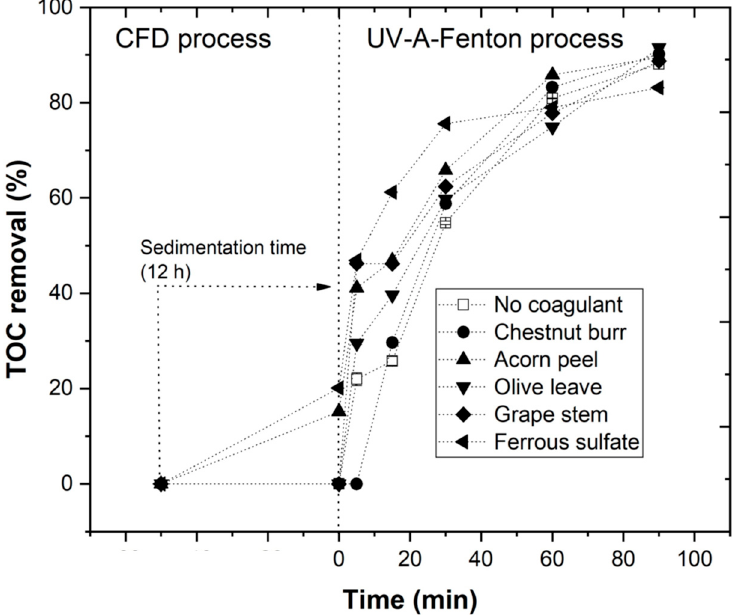
Figure 12. Progress of TOC percentage removal after CFD (with plant-based coagulants chestnut burr, acorn peel, olive leaf, and grape stem) and the UV-A-Fenton processes with the following experimental conditions: [H 2 O 2 ] = 38.8 mM, [Fe 2+ ] = 1.0 mM, pH = 3.0, agitation = 350 rpm, T = 25 °C, t = 90 min. Blank without coagulant and blank non-catalytic experiment (UV-A/H 2 O 2 ) are also represented as a reference.